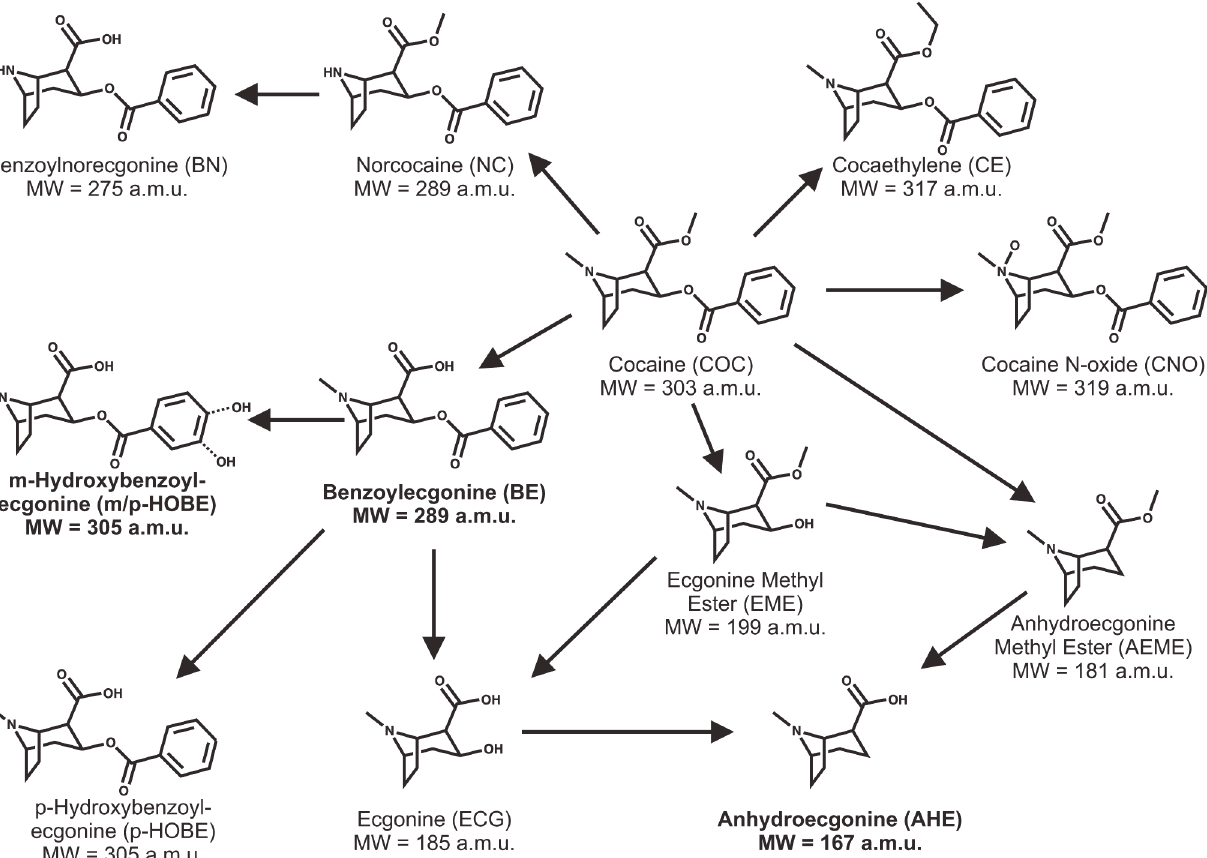
Fig 7. Metabolism of cocaine showing molecular weight for each metabolite. The linkages in this network were adapted from Xia et al . [30]. Putatively identified species are shown in